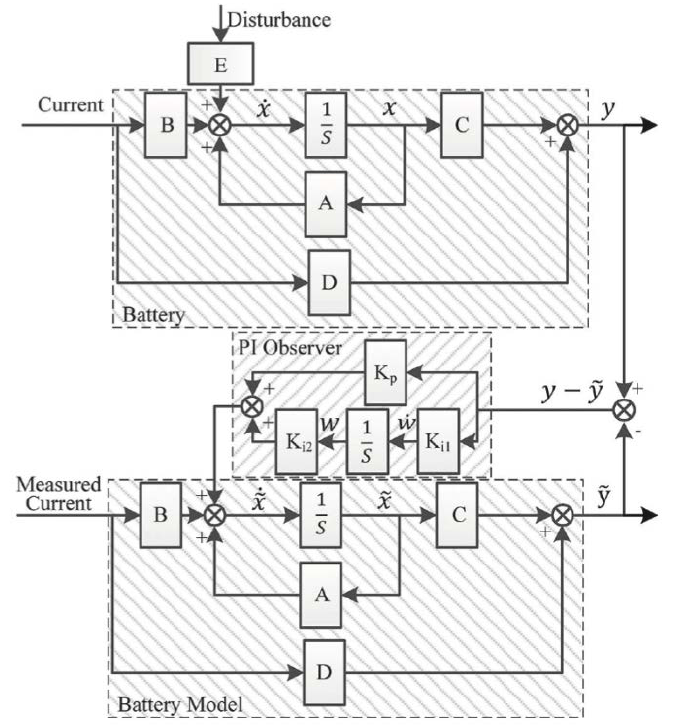
Figure 10. An example of the PIO algorithm for SOC estimation [128].